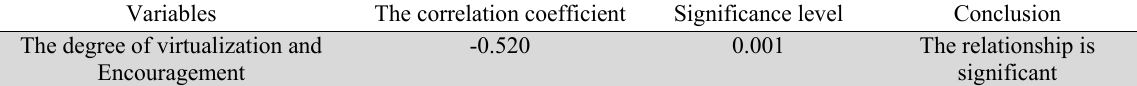
The results of testing the relationship between the degree of virtualization and Encouragement